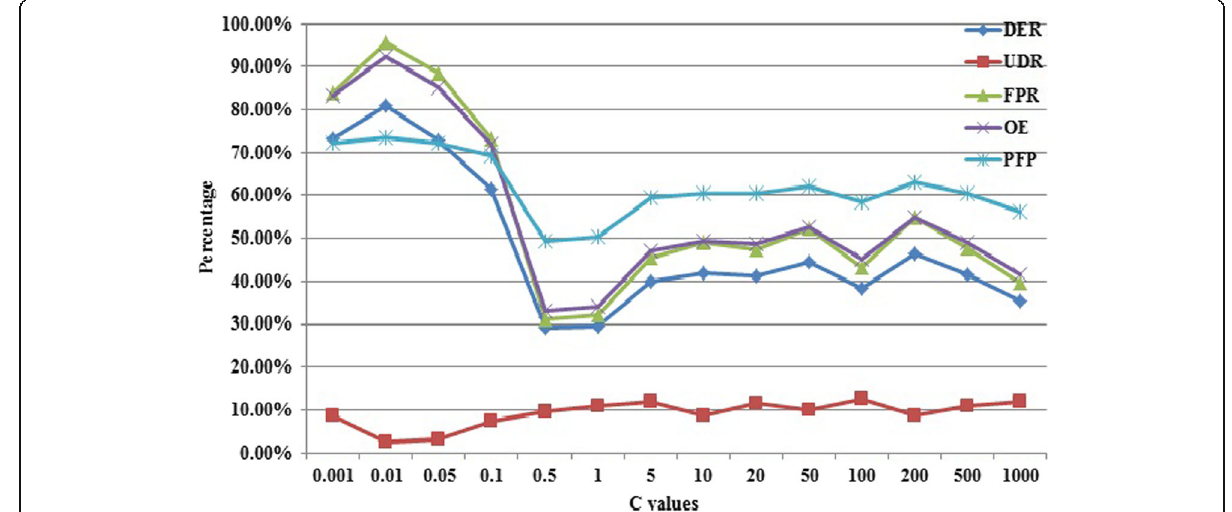
Fig. 4 The performance metrics of LSVM with different C values